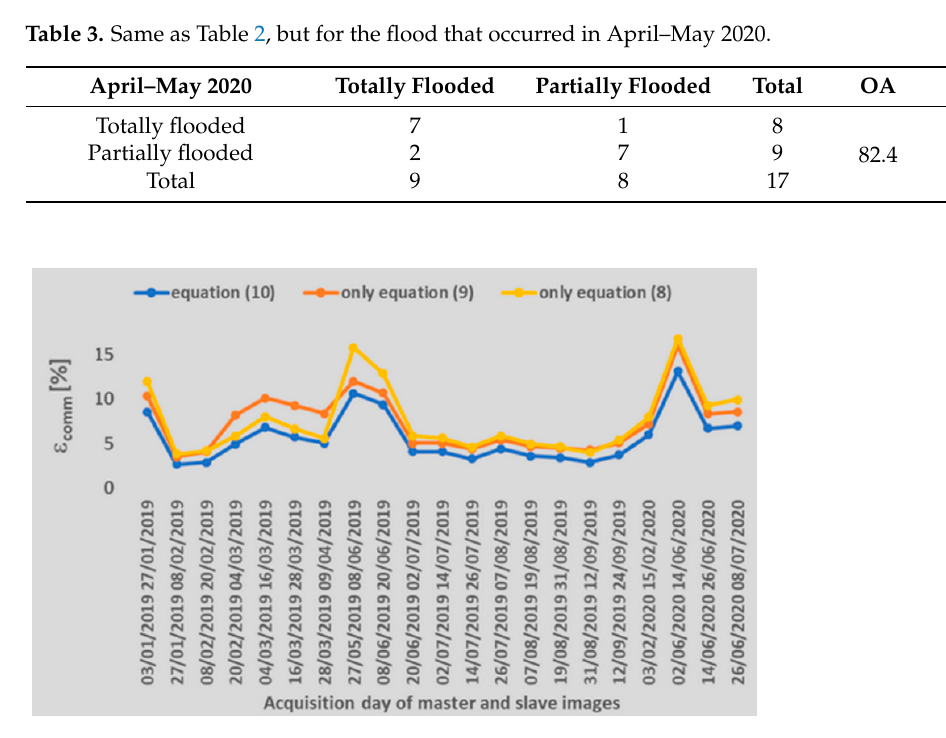
Figure 10. Temporal trend of the commission error for the validation period (except October–November 2019 and April–May 2020). Blue: flooded PSs identified according to Equation (10); red: flooded PSs identified based on Equation (9); yellow: flooded PSs identified according to Equation (8).